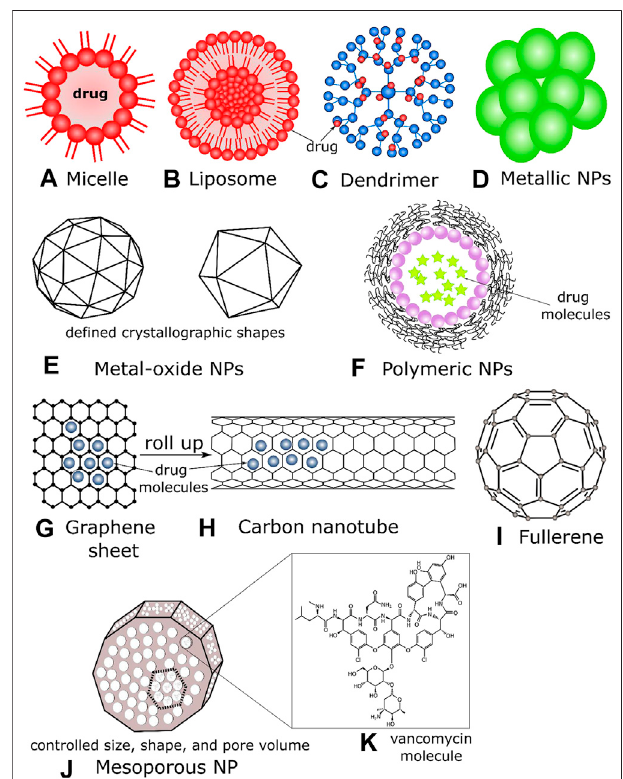
FIGURE 2 | Schematics of (A) a micelle, where drug molecules assemble to the polar heads of the lipid, (B) a liposome, drugs can be functionalized/contained inside the lipid bilayer, (C) a dendrimer containing a core moiety and branched polymers (active terminal surfaces) where antibiotics can be sequestered, (D) metallic NPs, usually composed of inorganic solids, drugs can be incorporated on their outer surfaces, (E) metal oxide NPs have de fi nite crystallographic architectures; their metallic and/or magnetic properties act as ef fi cient drug carriers and penetrates the bacterial cell membranes effectively, (F) polymeric NPs encapsulating drug molecules, (G) a graphene sheet (2D) with drug molecules, (H) a carbon nanotube that can be formed by rolling graphene sheets, (I) a fullerene NP (C60) (J) a mesoporous NP, where the individual size, shape, and pore volume can be controlleddepending ontheantibiotic ’ sstructures (K) themolecular structure of vancomycin antibiotics depicted to be in the pore and void volume of mesoporous